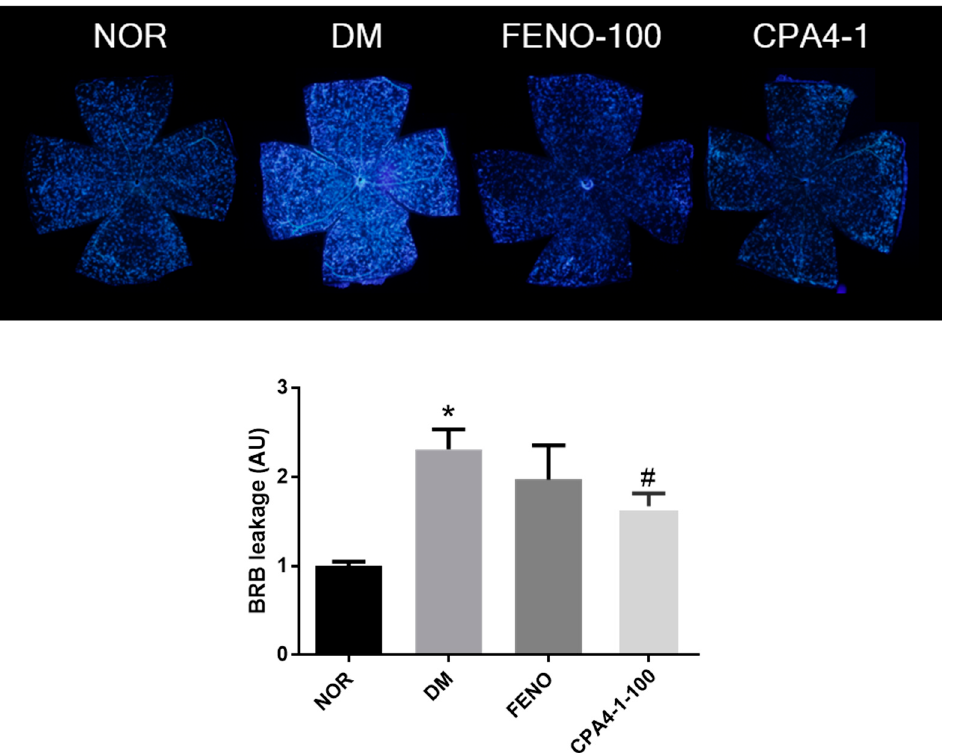
Figure 5. E ff ects of FENO and CPA4-1 on blood-retinal barrier (BRB) breakage in db / db mice. NOR, Figure 5. Effects of FENO and CPA4-1 on blood-retinal barrier (BRB) breakage in db/db mice. NOR, normal control mice; DM, db / db mice; FENO, db / db mice treated with fenofibrate (100 mg / kg); CPA4-1, normal control mice; DM, db/db mice; FENO, db/db mice treated with fenofibrate (100 mg/kg); CPA4- db / db mice treated with CPA4-1-100 (100 mg / kg). All data are expressed as mean ± SE. * p < 0.05 vs. 1, db/db mice treated with CPA4-1-100 (100 mg/kg). All data are expressed as mean ± SE. * p < 0.05 vs. NOR group. # p < 0.05 vs. DM NOR group. # p < 0.05 vs. DM group.